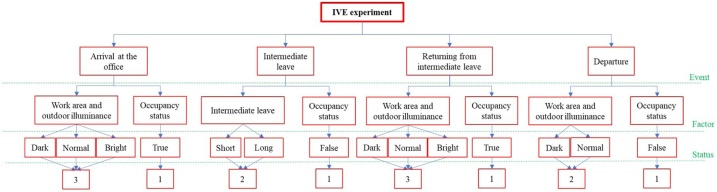
Diagram of factors included in the IVE experiment [1].